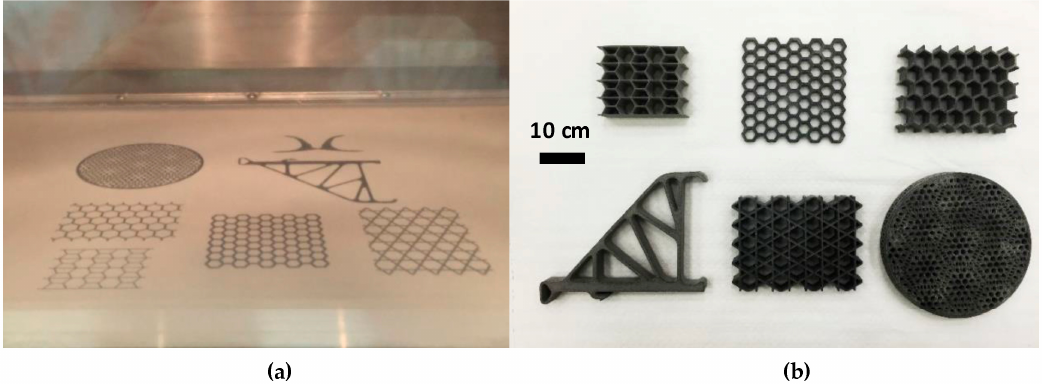
Figure 9. ( a ) The building platform of EOS P395 with the dimension of X , Y , Z (34 cm × 34 cm × 60 cm); ( b ) Light-weight CNTs/PA12 parts with complex geometric manufactured by SLS.